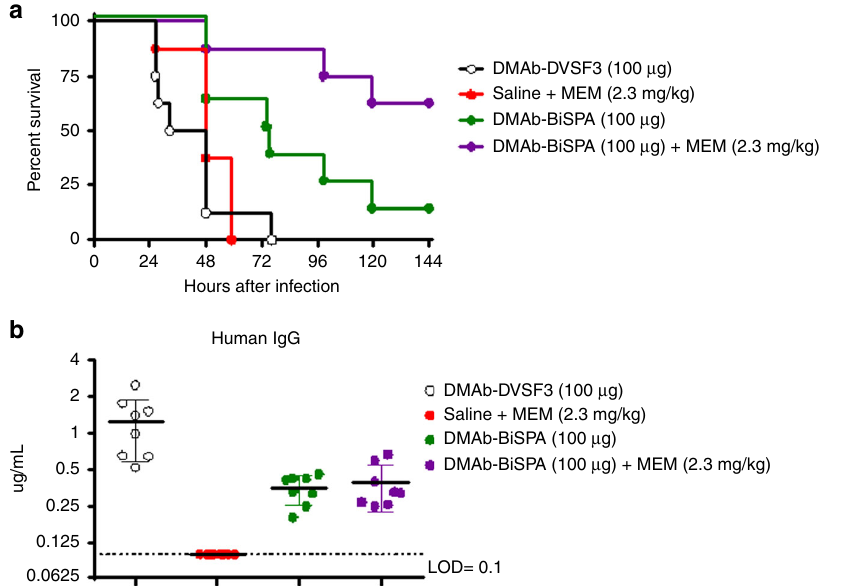
Fig. 7 DMAb combination with antibiotic regimen. a BALB/c mice were injected with control DMAb-DVSF3 (100 µ g), saline + MEM (2.3 mg kg − 1 ), DMAb-BiSPA (100 µ g), or DMAb-BiSPA (100 µ g)+ MEM (2.3 mg kg − 1 ) and then challenged with a lethal dose of P. aeruginosa 6077. MEM was administered 1 h post lethal challenge. Animals were monitored for 144 h post infection. n = 8 mice/group. b DMAb serum levels in animals before lethal challenge. n = 8 mice/group. The line represents the mean value and error bars represent standard